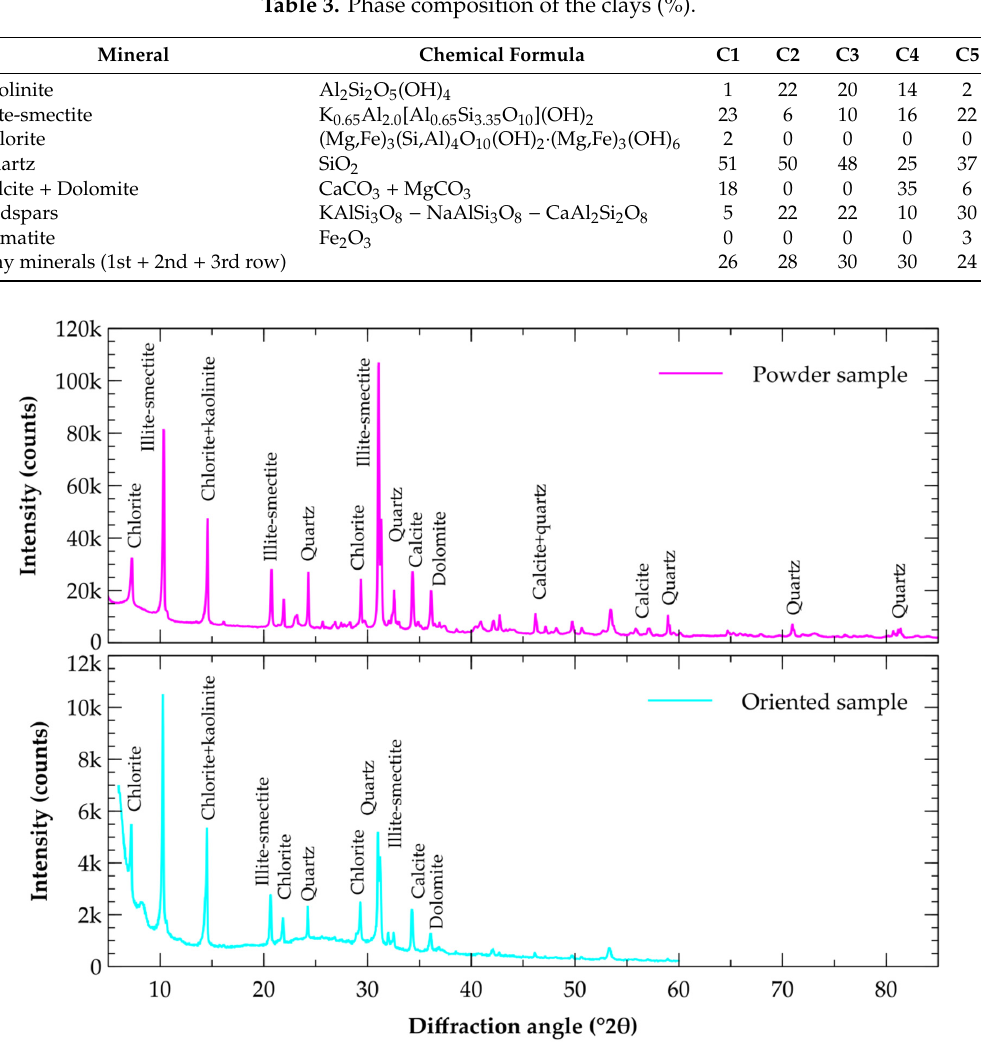
Figure 3. Heat flow diagrams and relative mass change of the clays.